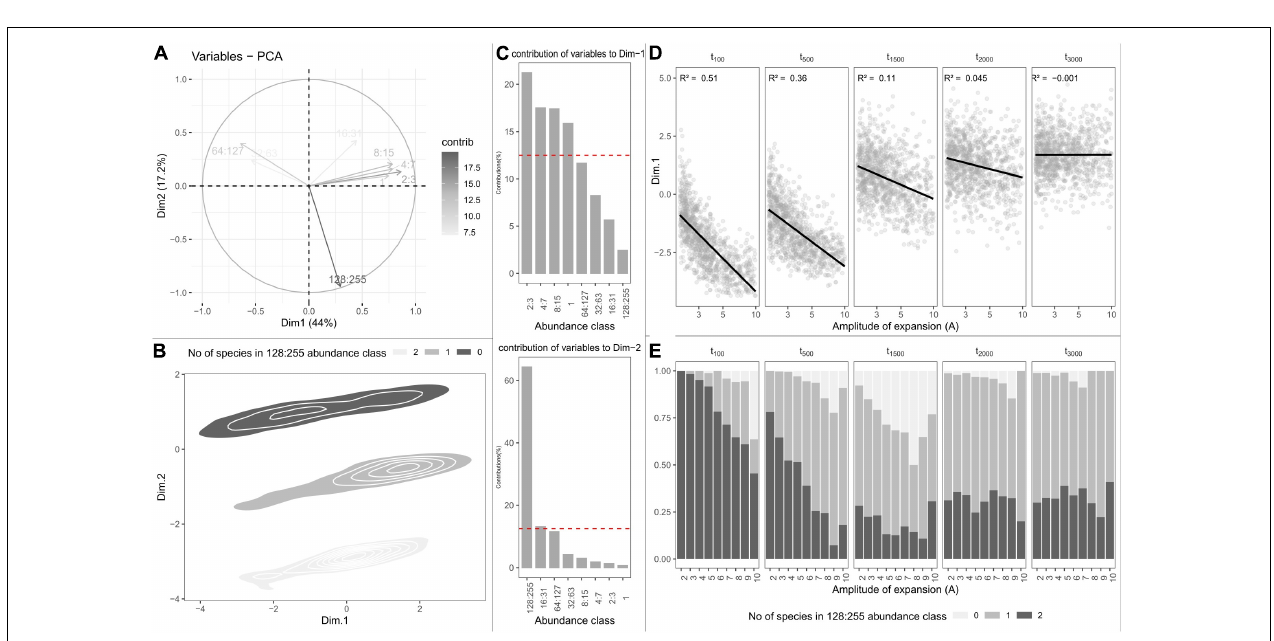
FIGURE 3 | Variation in simulated species richness depending on the amplitude of expansion (A) and the time (in generations) at which it occurred (t c ). Linear regressions are shown in black with the associated R 2 statistic in the upper-right side of each panel.